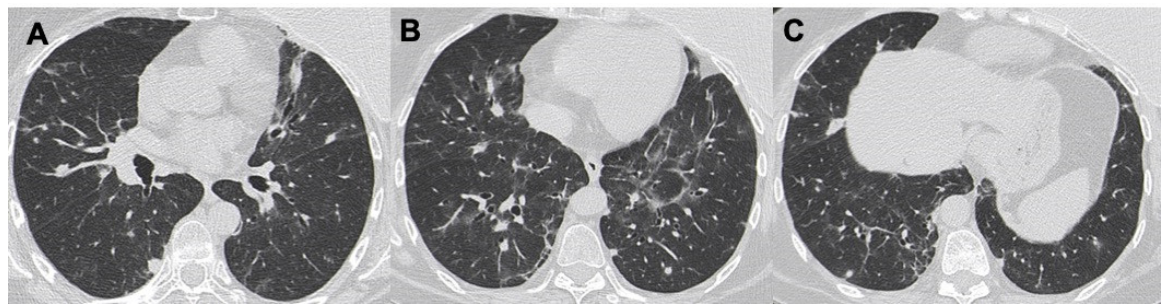
izing pneumonia).